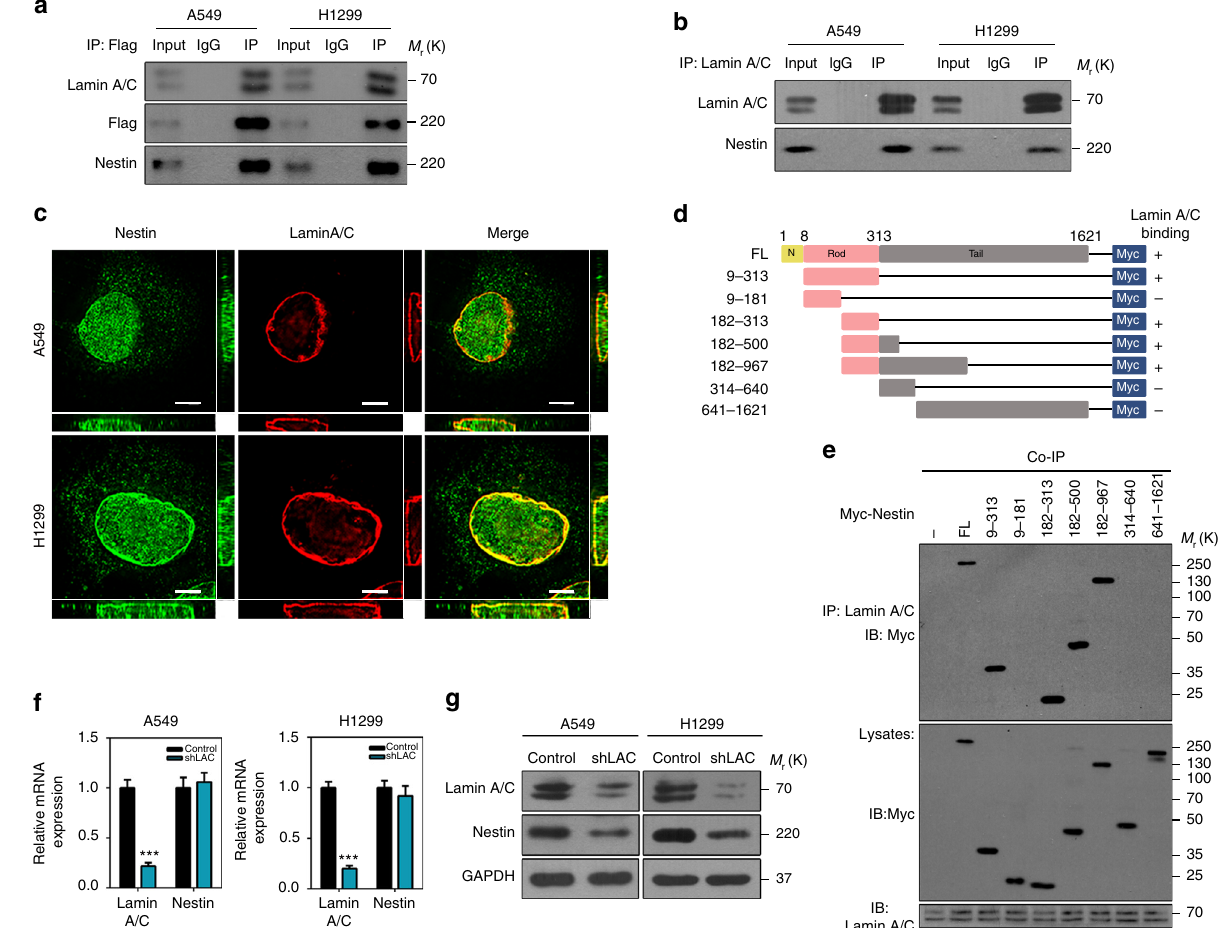
Fig. 4 Nestin interacts with lamin A/C. a Coimmunoprecipitation of Flag-Nestin and lamin A/C from A549 and H1299 cell lysates with anti-Flag antibody. IgG was used as a negative control for the immunoprecipitation. b Coimmunoprecipitation of endogenous lamin A/C and Nestin from A549 and H1299 cell lysates with anti-lamin A/C antibody. c Immuno fl uorescence staining of Nestin (green) and lamin A/C (red) for their subcellular localization in lung cancer cells. Micrographs were obtained and analyzed by SIM. The images on the right and at the bottom highlight the co-localization of Nestin and lamin A/C. Scale bars, 5 μ m. d Schematics of the utilized Myc-Nestin constructs. e Coimmunoprecipitation of endogenous lamin A/C and the indicated ectopically expressing constructs in HEK293T cells with anti-lamin A/C antibody. f qPCR analysis of Nestin expression in control and lamin A/C-knockdown cells. g Immunoblotting analysis of Nestin expression in control and lamin A/C-knockdown cells. For all quanti fi cations, the data represented the mean ± SEM of three independent experiments, as assessed using unpaired t -test; *** P <